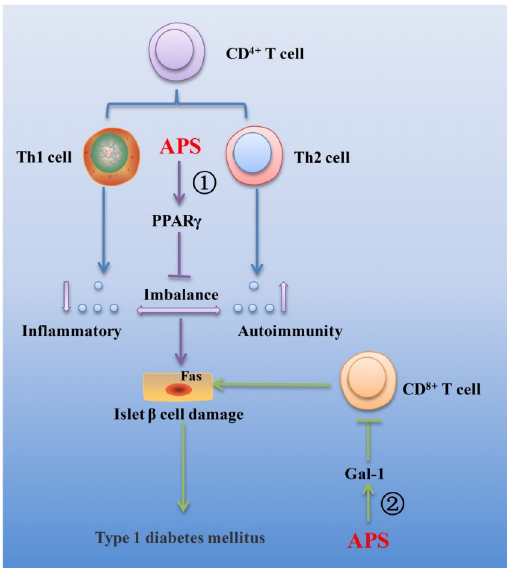
Figure 2. Several mechanisms linking AR and its main components to the treatment of type 1 diabetes mellitus. Arrows and bar-headed lines represent signaling activation and inhibition, respectively. The different signaling pathways regulated by AR and its components are numbered ① to ② .